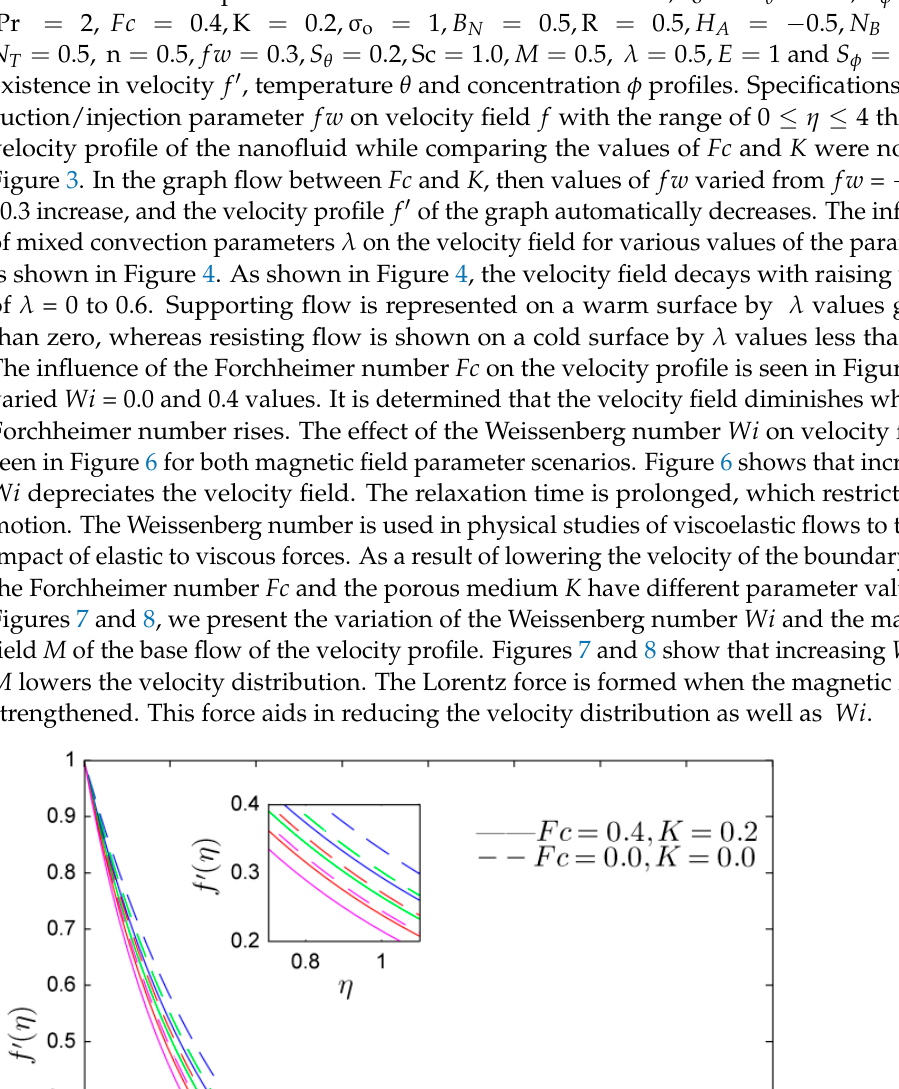
Figure 4. Effect of Richardson number (𝜆) on 𝑓 (cid:4593) (𝜂) . Figure 5. Effect of Forchheimer number (𝐹𝑐) on 𝑓 (cid:4593) (𝜂) .